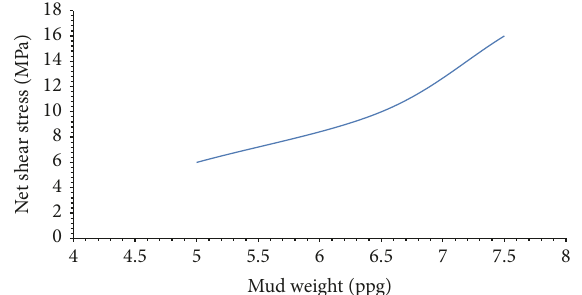
Figure 20: Relationship between mud weight and net shear stress (iteration process).